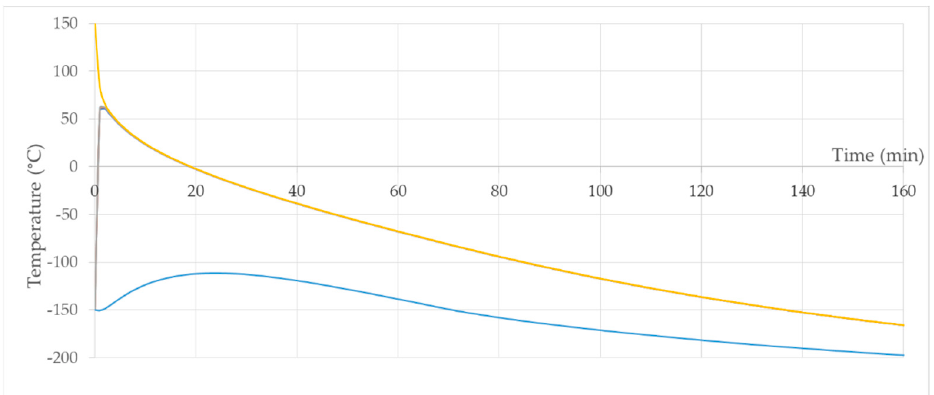
Figure 12. Cooldown time simulation.